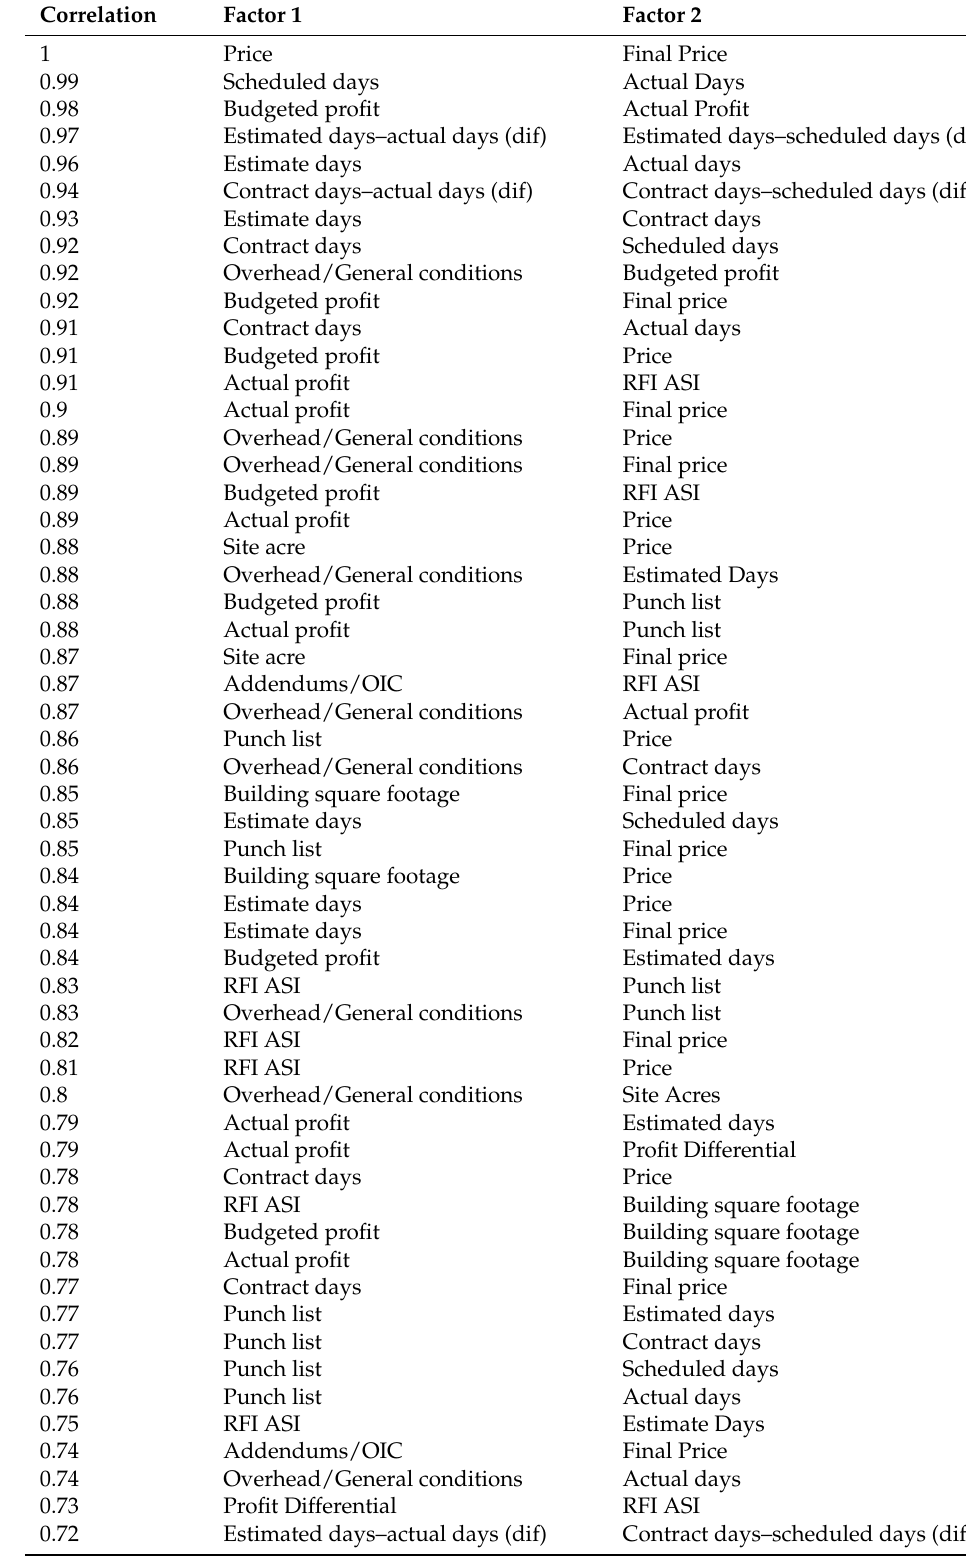
Table 4. Project group dataset significant correlation factors